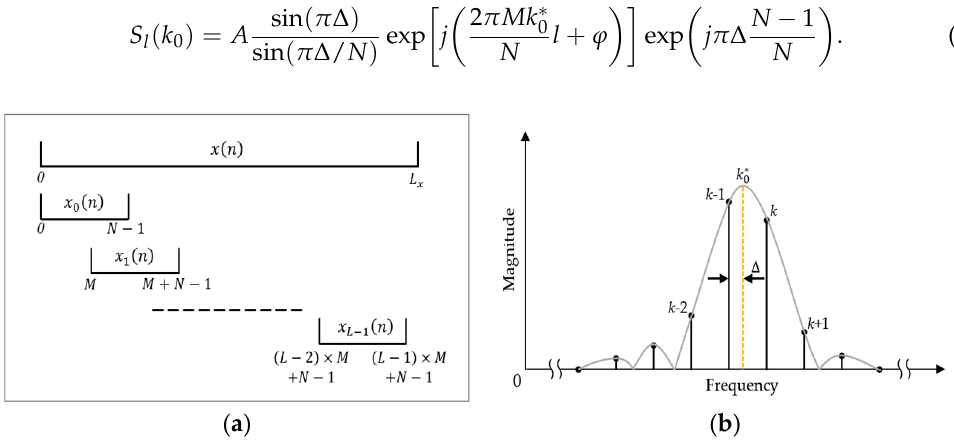
is closer to k + 1. 0